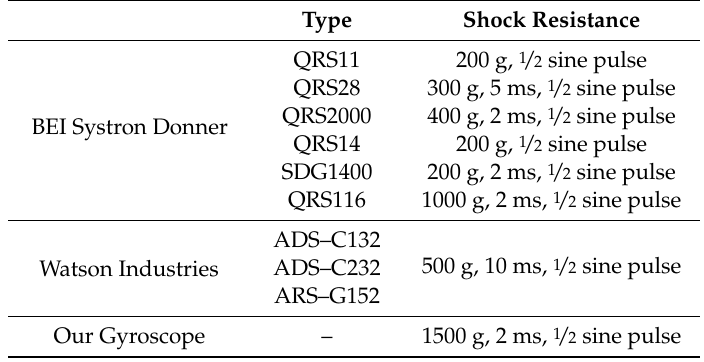
Table 4. Comparison of existing shock resistance technology and this